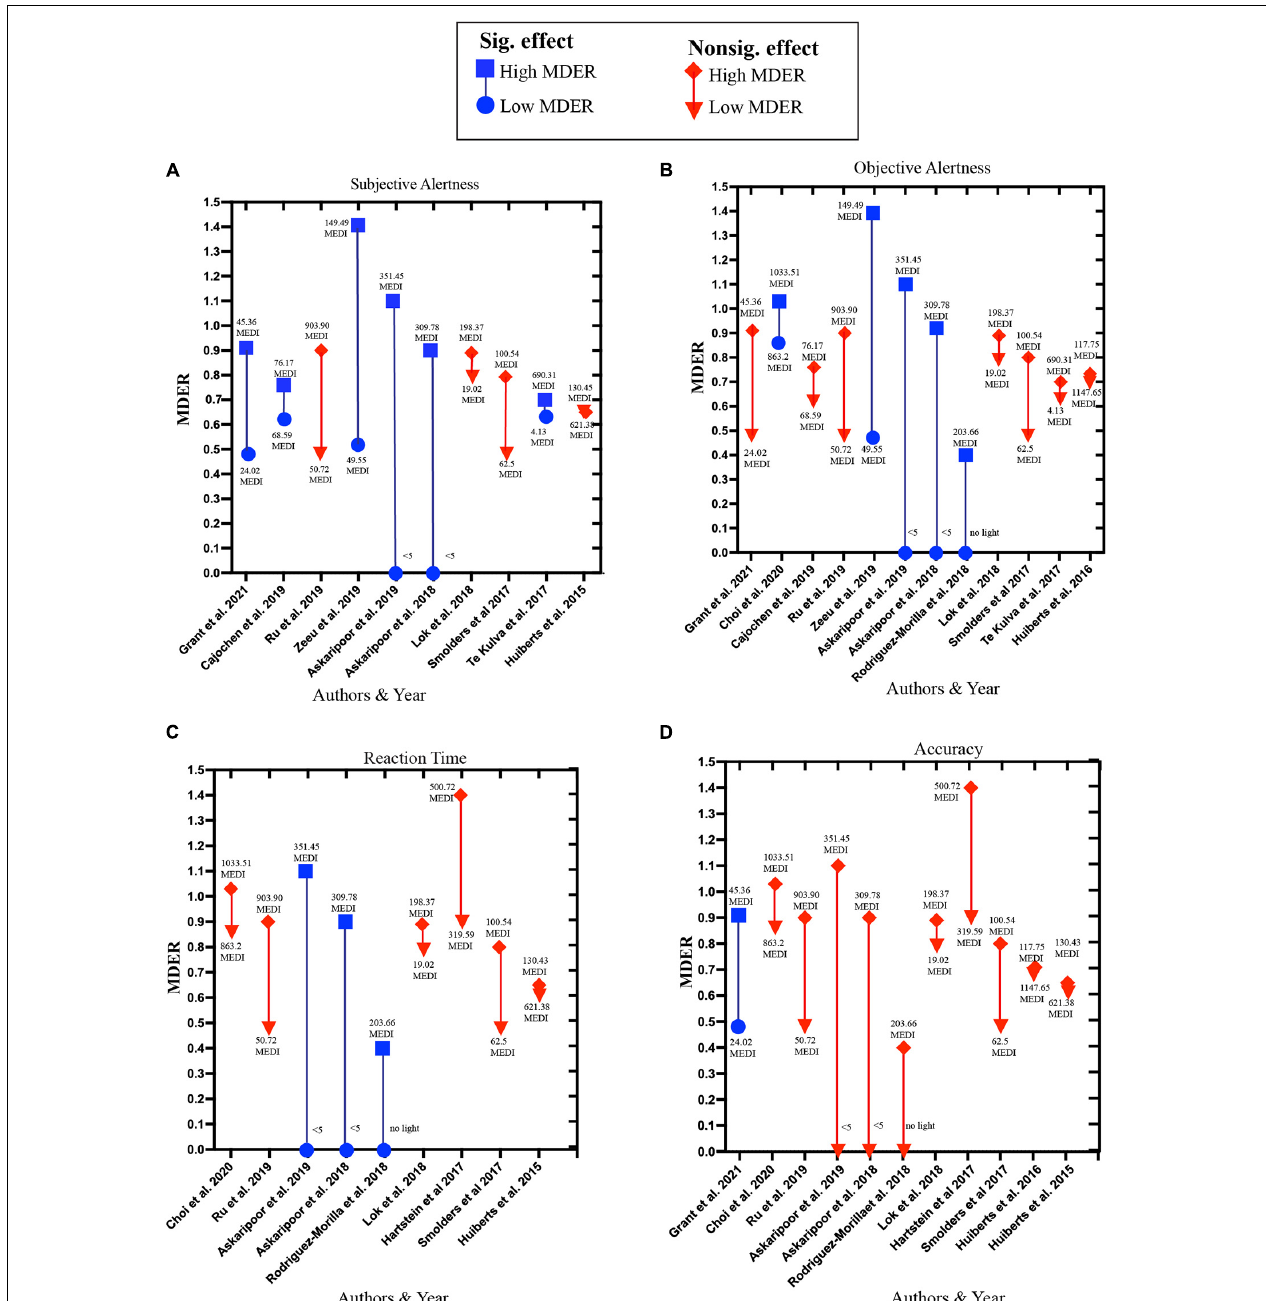
FIGURE 7 | Influence of high MDER light exposure on (A) subjective alertness, (B) objective alertness, (C) reaction time, (D) accuracy. Blue squares represent high MDER light exposure in a study that reported significant beneficial effects; the corresponding blue circle represents low MDER light exposure used in the same study. The red diamond shape represents high MDER light exposure that reported insignificant effects or significant deteriorating effects. The corresponding inverted red triangle represents low MDER light exposure used in the same